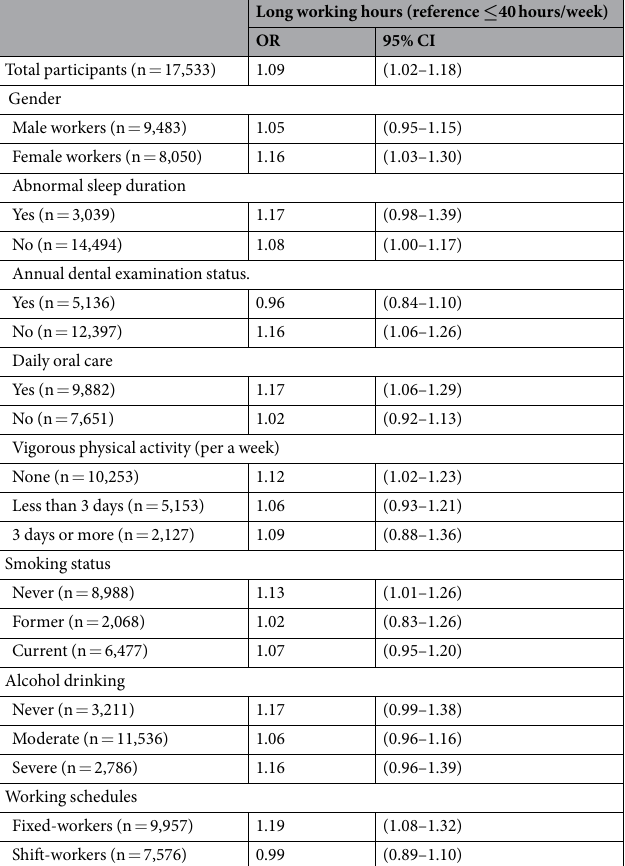
Table 3. Odds Ratio (OR) and 95% confidence interval (CI) for periodontitis according to long working hours with subgroup analysis. All models were adjusted for age, sex, socioeconomic status (educational level and household income level), occupational classification, job position, health behaviour (alcohol drinking, smoking, physical activity level, and daily sleep duration), chronic disorders (metabolic syndrome), and dental care (daily dental care and annually dental examination) except a stratified variable,